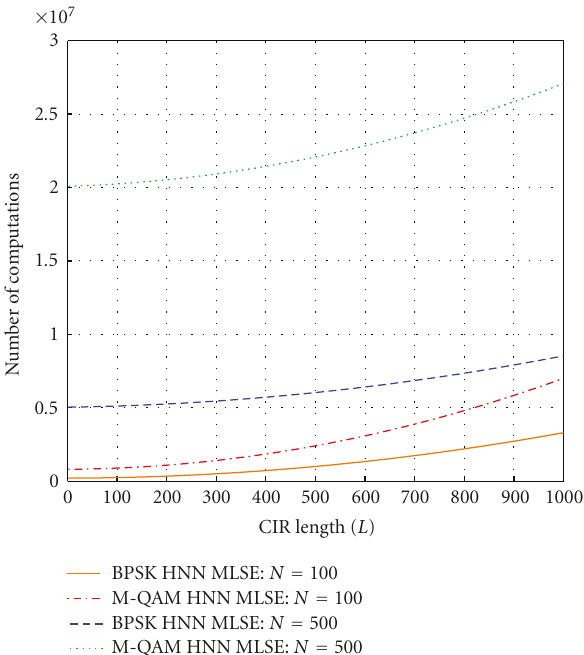
Figure 11: Computational complexity comparison for the HNN MLSE equalizers for di ff erent data block lengths.